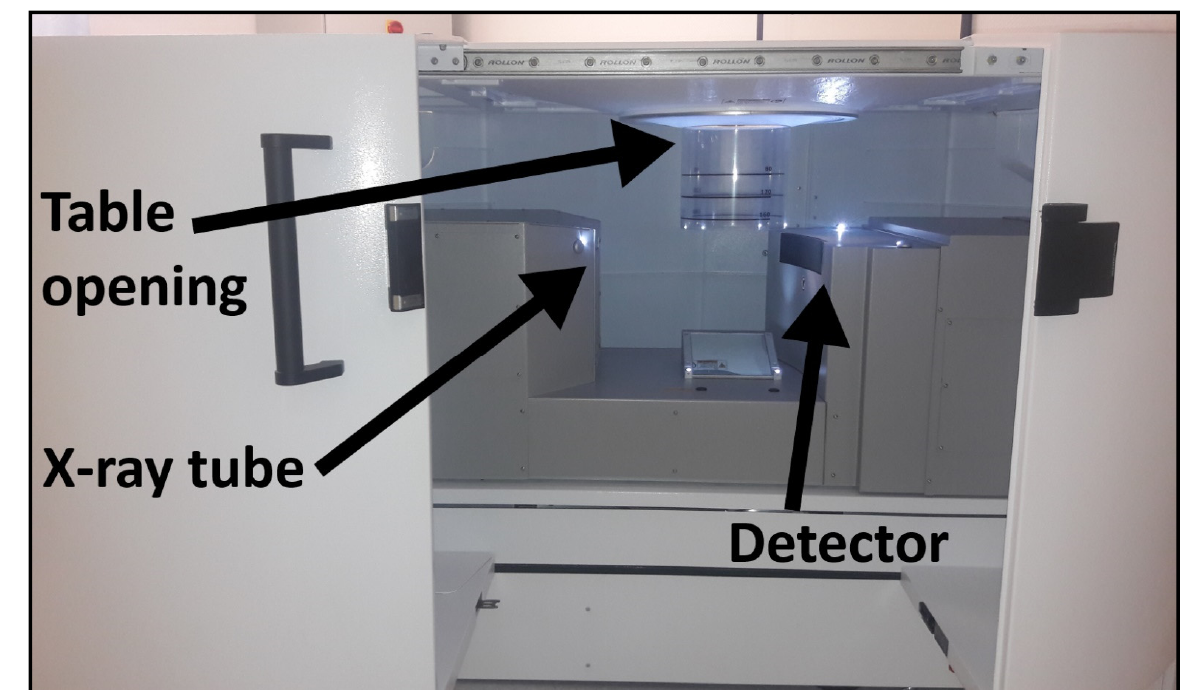
Figure 1. Design of the dedicated spiral breast CT. The patient lies on the patient table in prone position. The concave shape of the patient table around the table opening enables imaging of breast tissue up to the chest wall. The breast hangs freely through the table opening and is covered by a cylindric safety cover. The x-ray tube/detector unit rotates on a spiral path around the breast.